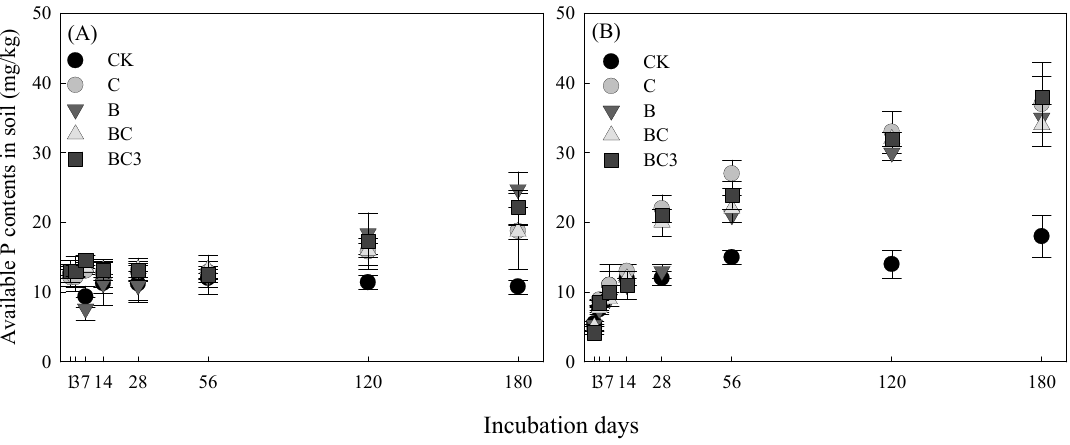
Figure 3. Dynamic changes to the available P content during the experiment period ( A ) sandy soil ( B ) clay soil.